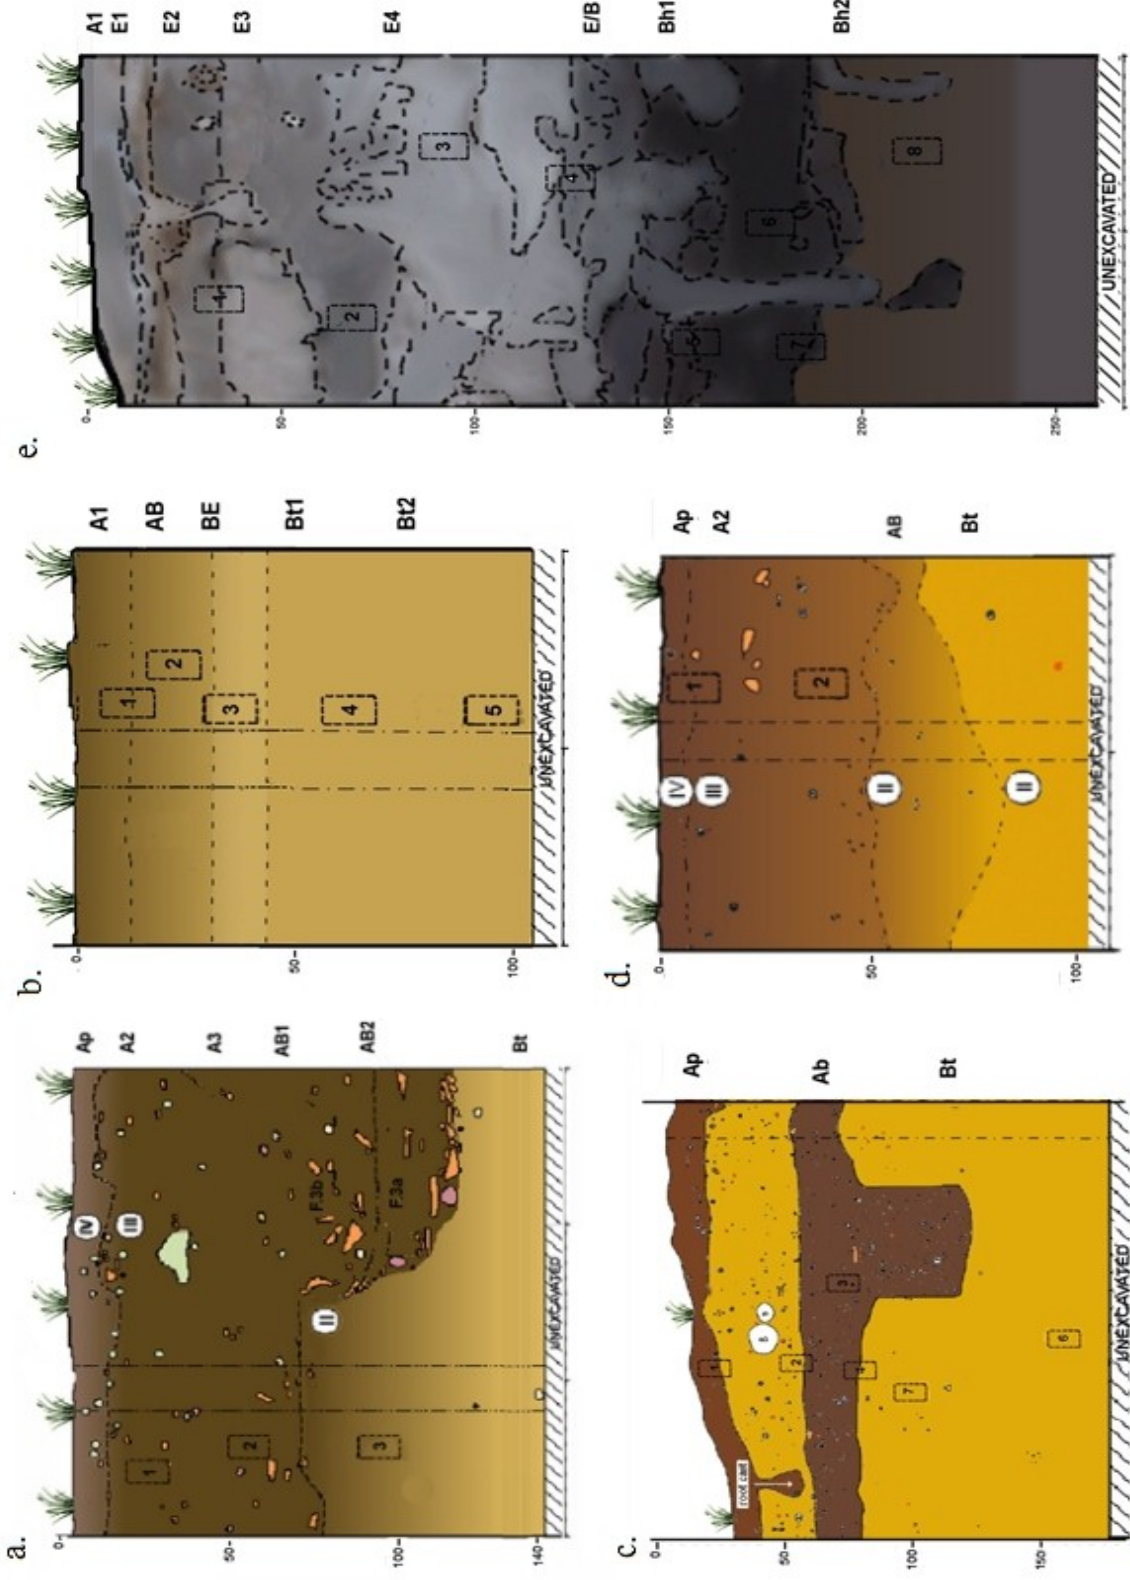
Figure 4. Profiles discussed in the text. (a) Hatahara site (see also Figure 2, bottom). (b) Control profile with sub-recent burning, same landform as Hatahara. (c) and (d) Lago Grande site: buried and exposed terra mulata profiles. (e) Dona Stella